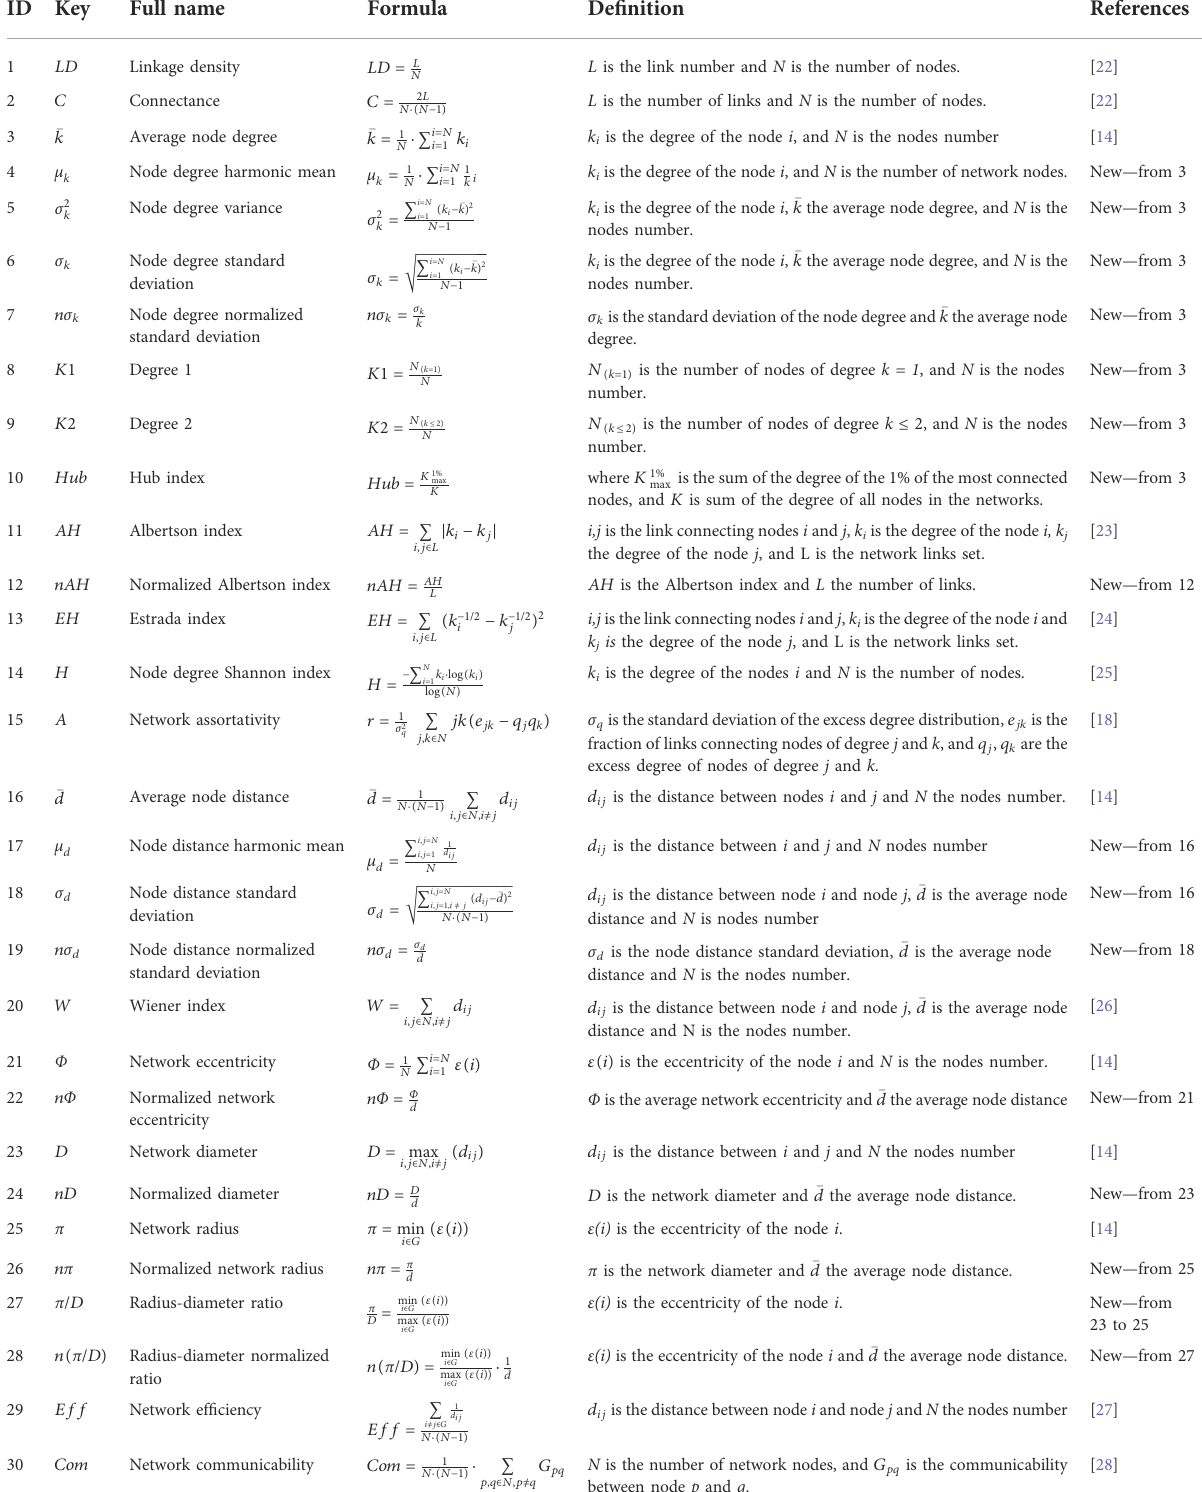
TABLE 2 Network structural indexes (NSI) list. For the NSIs from the literature is indicated the reference between square brackets; for the new NSIs is indicated “ new ” and the NSI number from they are